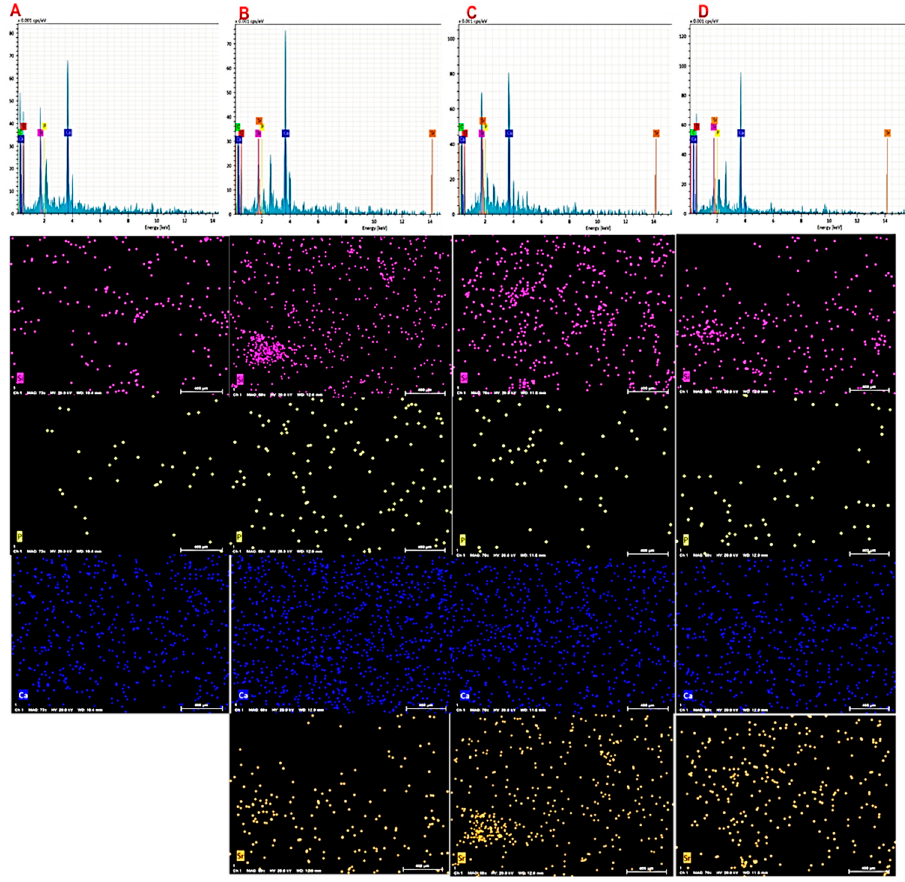
Figure 3. EDS mapping of Si (purple), P (yellow), Ca (blue), and Sr (orange) of prepared scaffold: ( A ) Alg/BG 10%, ( B ) Alg/Sr-BG 5%, ( C ) Alg/Sr-BG 10%, and ( D ) Alg/Sr-BG 15%.